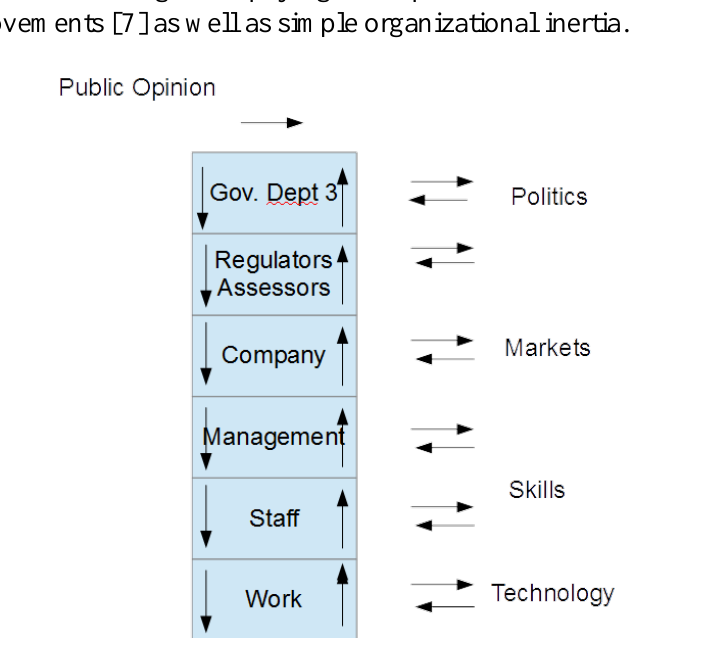
Figure 2. A Complex Socio-technical Organization (adapted from [5])